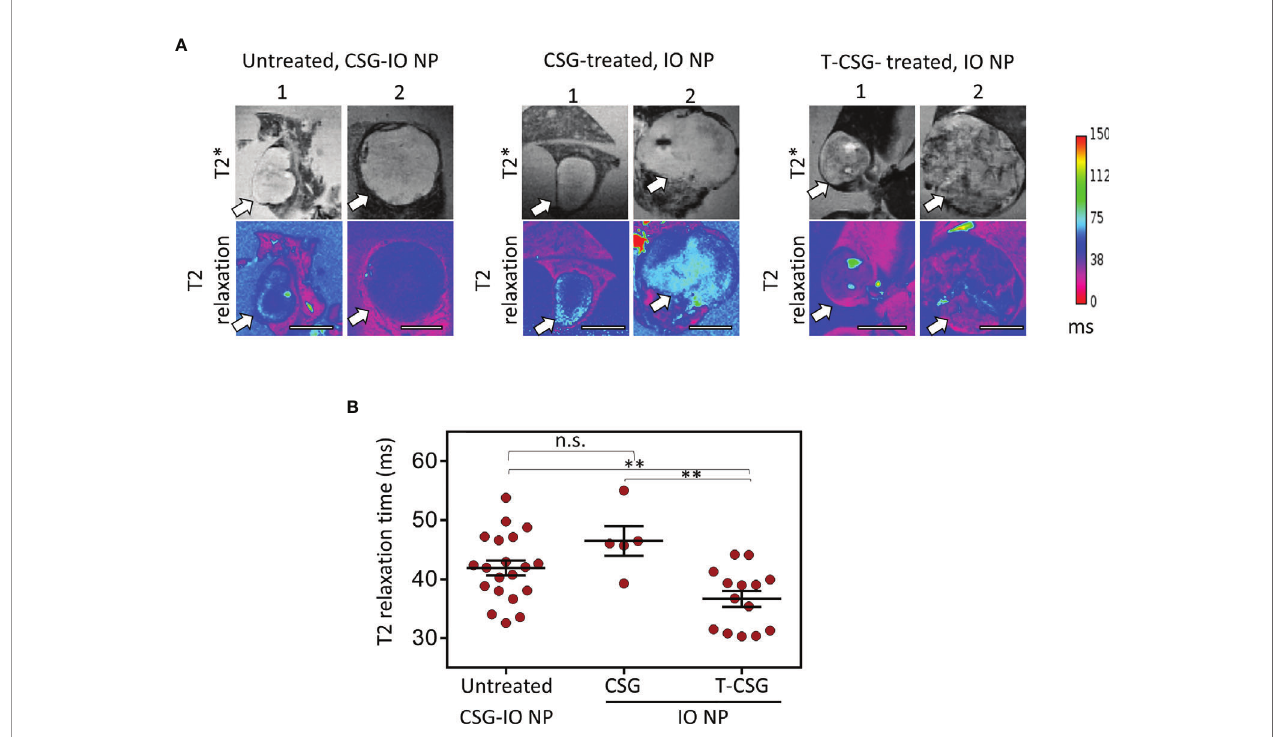
FIGURE 3 | Accumulation of CSG-IO-NP and IO-NP in HCC with intact and/or reduced ECM detected by MRI. (A) Representative images of T2*-weighted (top) and T2 relaxation maps (magenta, bottom) from ex vivo MRI scans of liver with HCC (tumor sizes, <5 mm and >5 mm in diameter, indicated by arrow). Scale bars: 4 mm. Left: HCC with intact ECM after 4 h in vivo circulation of CSG-IO-NP. Middle: HCC treated with 5 × 0.8 µg CSG peptide and then i.v.-injected with untargeted IO-NP. Right: HCC treated with 5 × 5 µg TNF a -CSG and then i.v.-injected with untargeted IO-NP. (B) Reduction in T2 relaxation time indicates the relative increase of IO-NP in individual tumors and mean ± SEM per group (**P < 0.01 and n.s. when P > 0.05 by one-way ANOVA